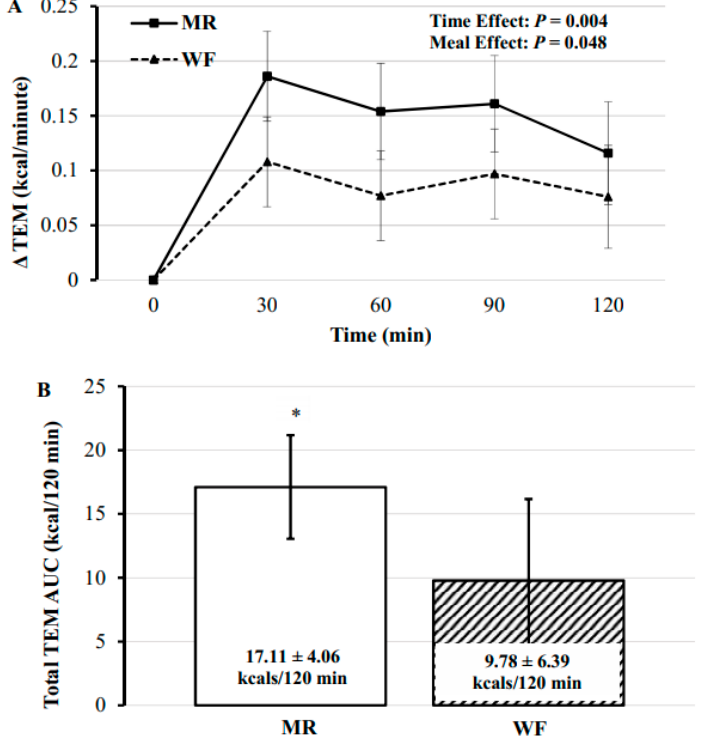
Figure 2. ( A ) Postprandial change in TEM across 120 min for each meal. ( B ) Effect of test meals on the 120 min postprandial period area under the curve (AUC) for thermic effect of meal following the two test meals. MR: meal replacement meal; WF: whole food meal. Data displayed as mean ± standard error. * MR significantly higher TEM than WF; p < 0.05.